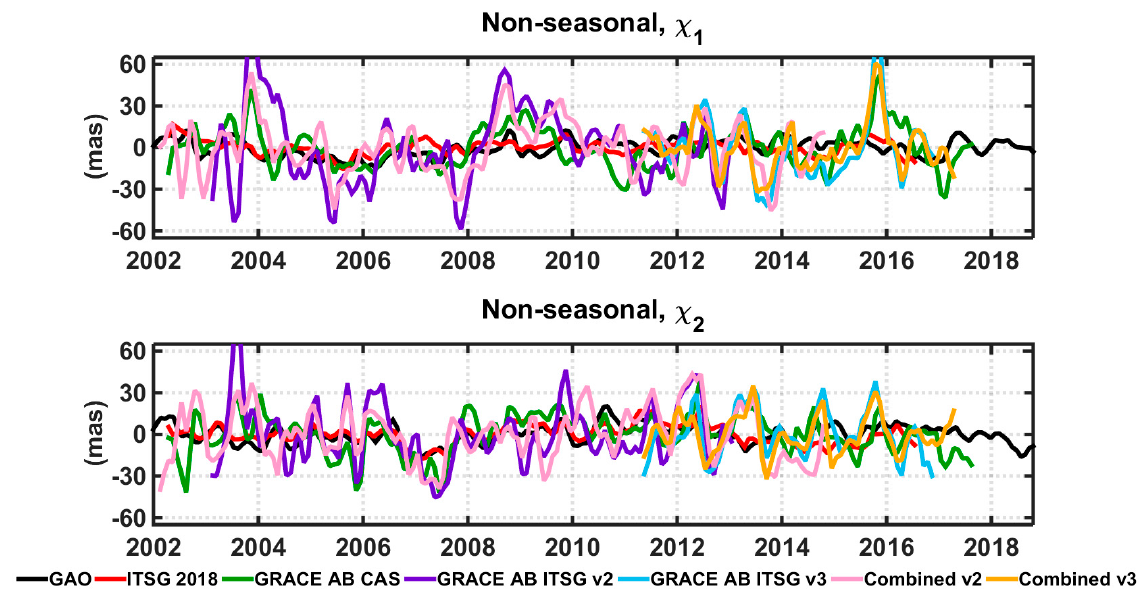
Figure 4. The χ 1 and χ 2 non-seasonal (after removing seasonal) components of GAO and HAM obtained from: (1) ITSG 2018 GRACE solution (ll-SST), (2) solutions based on kinematic orbits of GRACE satellites (hl-SST), and (3) combined solutions (hl-SST).